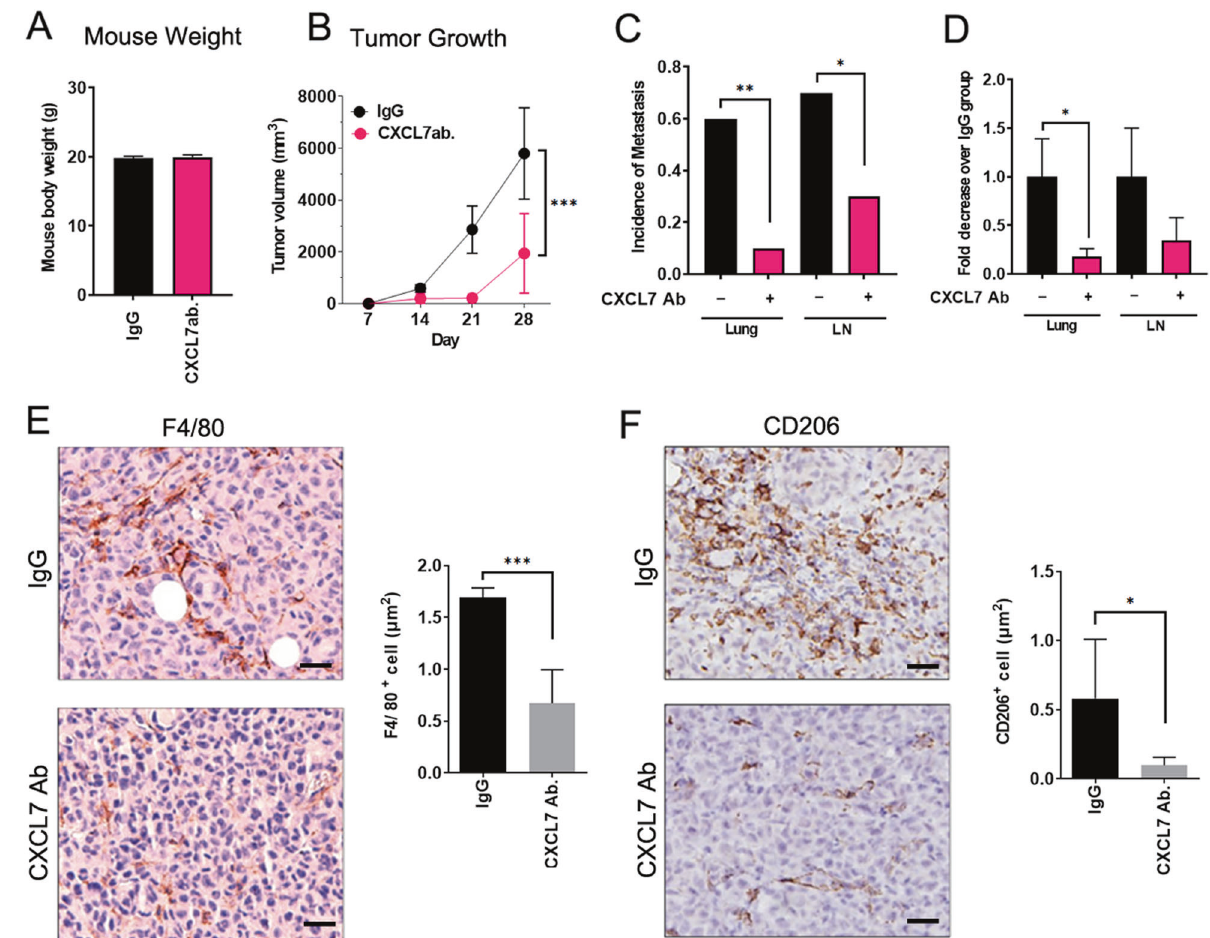
Fig. 4 Blocking CXCL7 by a neutralizing antibody suppresses tumor growth and distant metastasis in a mouse xenograft model. 1 × 10 6 IV2 cells were orthotopically injected into the 4 th mammary fat pad per mouse. Seven days after implantation, intratumoral injection of a CXCL7 antibody (1 mg/kg) or equivalent amount of control IgG 1 was started once a week until the endpoint. A – D The mouse weight ( A ) and the tumor growth curve ( B ). Data are means ± SEM ( n = 9 or 10 mice per group; data were combined from two independent experiments). Two-way ANOVA was used for the statistical analysis ( p < 0.001). The incidence of metastasis ( C ) and relative amounts of metastatic cells ( D ) from individual lung or axillary lymph nodes (LN) were determined and measured by human speci fi c GAPDH levels to quantify relative number of metastatic IV2 cells. Data are normalized to the means of the IgG 1 control group ± SEM ( n = 9 or 10 mice per group; data were combined from two independent experiments; * p < 0.05; ** p < 0.01). E , F Immunohistochemical analysis of paraf fi n-embedded xenograft breast tumors using F4/80 ( E ) and CD206 ( F ) antibodies. The number of positive labeled cells per μ m 2 was quanti fi ed. Scale bars: 20 μ m. Data are presented as means ± SEM ( n = 5 mice per group; * p < 0.05; *** p <